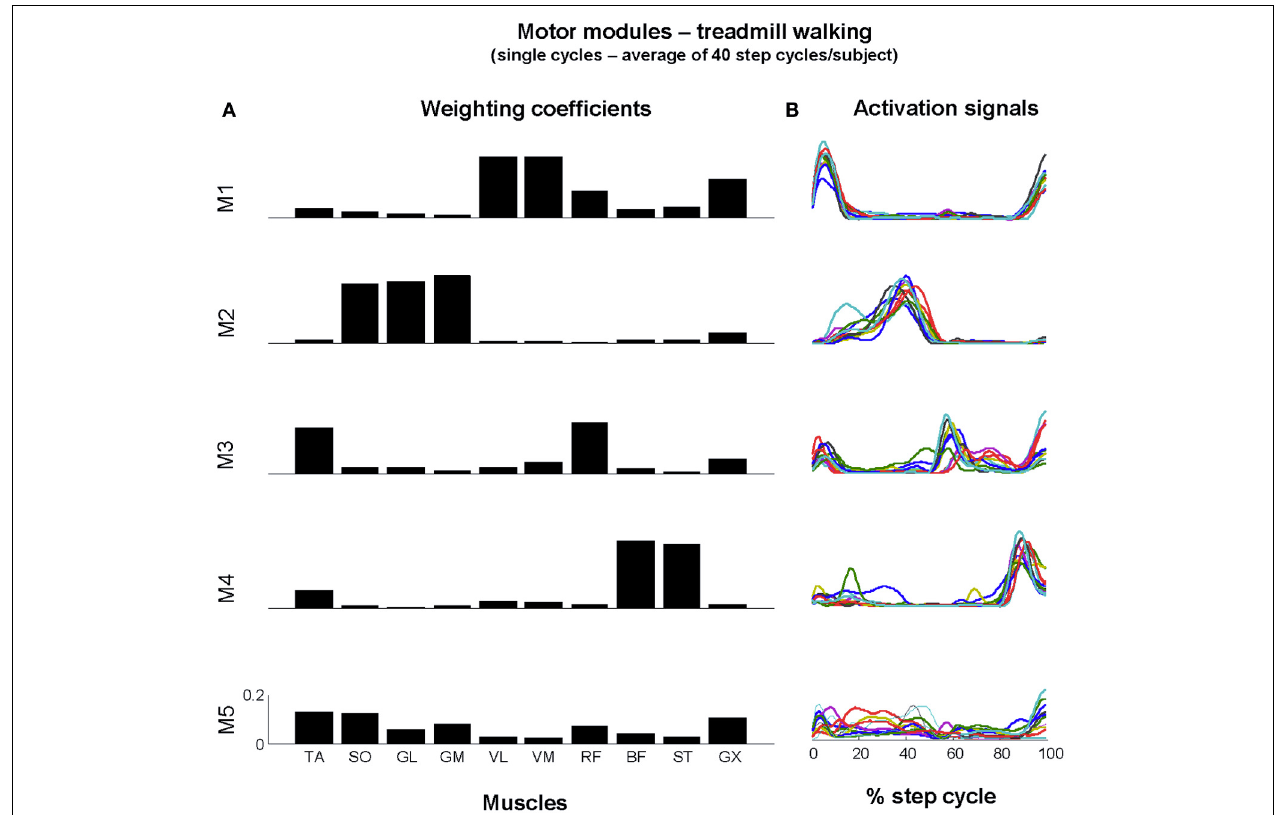
FIGURE 3 | Motor modules extracted from EMG AVR of all subjects concatenated. Muscle weightings were averaged for illustration (A) and each activation signal for single subjects (each subject represented by a color)